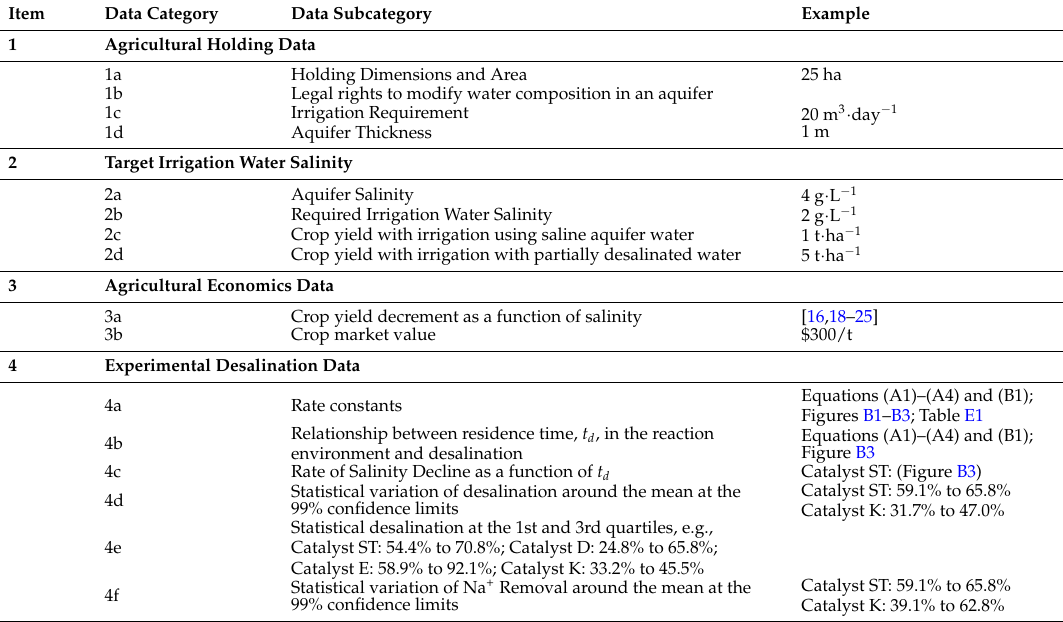
Table 1. Example set of primary data required to reconstruct an Aquifer Treatment Zone